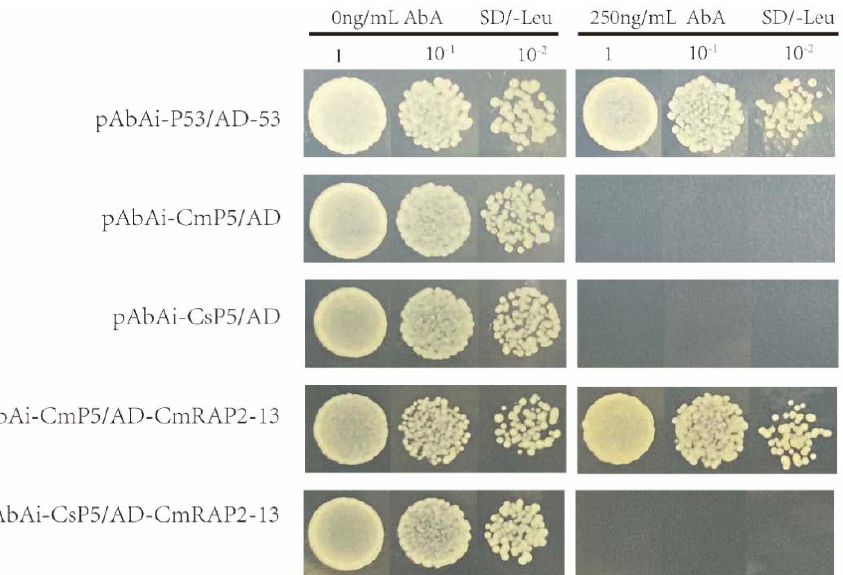
Figure 9. Promoter interactions with selected transcription factors. TFs (RAP2-13) bind to the BAK1 promoter in yeast. Bait strain Y1HGold[pBait-AbAi] yeast cells were transformed with a prey vector containing RAP2-13 fused to a GAL4 activation domain. Cells were grown in liquid media to OD 600 of 1 (10 0 ) and diluted in a 10× dilution series (10 − 1 to 10 − 3 ). For each dilution, 10 μL was spotted on media selecting for both plasmids (SD/−Leu) and selecting for the interaction (SD/−Leu/AbA 250 ), supplemented with 100 ng mL − 1 AbA to suppress background growth.